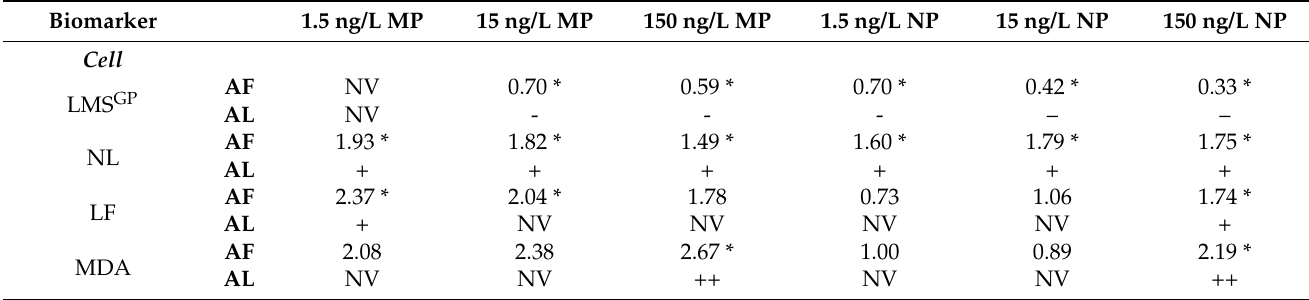
Table 1. Output of the Mussel Expert System (MES) assigning a unique health status index (HSI) to mussels exposed for 21 days to increasing concentrations of PS-MP and PS-NP.